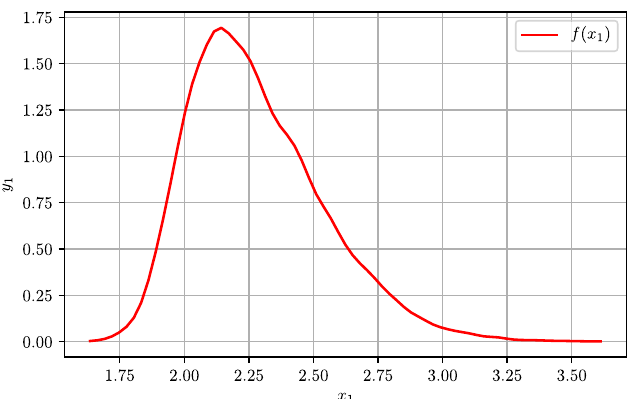
Fig. 6. Visualization of the Rosenblatt marginal density f ( x 1 ) .